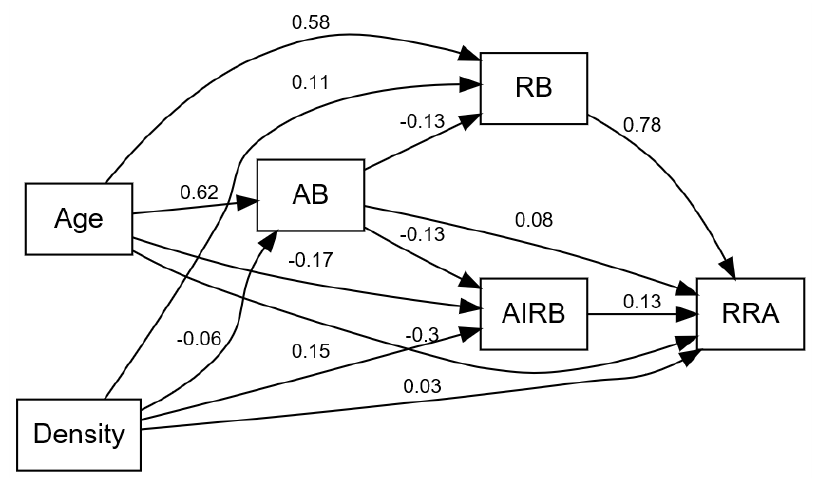
Figure 4. Structural equation models (SEM) of stand age, stand density, AB on RB, AIRB and RRA. Standardized coefficients are listed beside each pathway. AB aboveground biomass per ha (Mg/ha), RB forest root biomass per ha (Mg/ha), AIRB annual increment of root biomass per ha (Mg/ha/year), RRA ratio of root biomass per ha and aboveground biomass per ha.